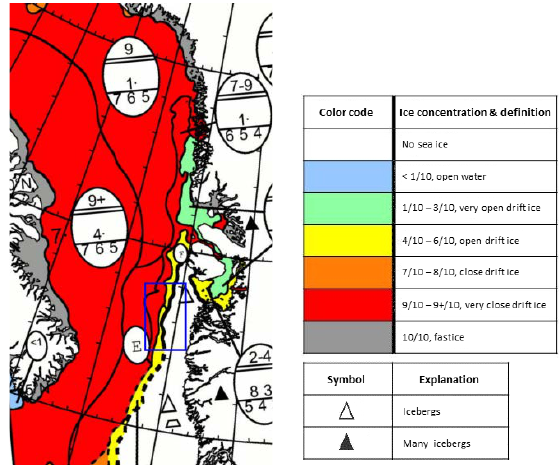
Figure 8. Ice concentration according to DMI for 2014/05/25. Egg code for segments according to WMO. The blue rectangle indicates the location of the TerraSAR-X image shown in Figure